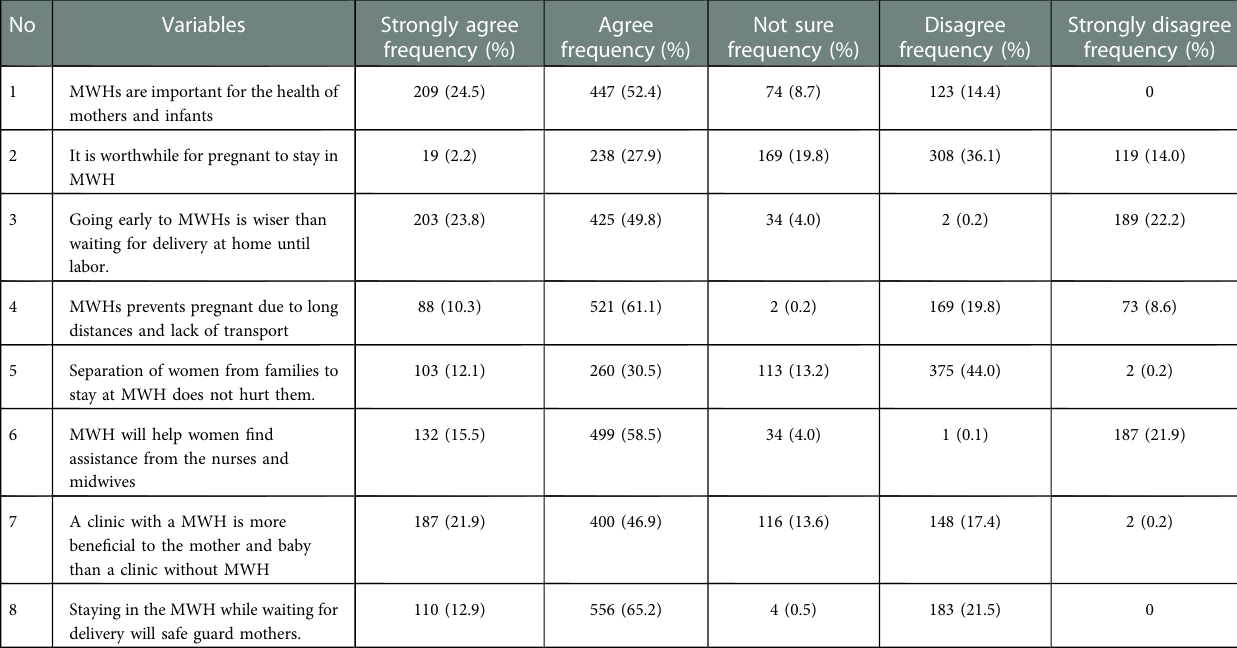
TABLE 4 Attitude of women towards MWH services in Dega Damot district, northwest Ethiopia, 2021 ( n =853). No